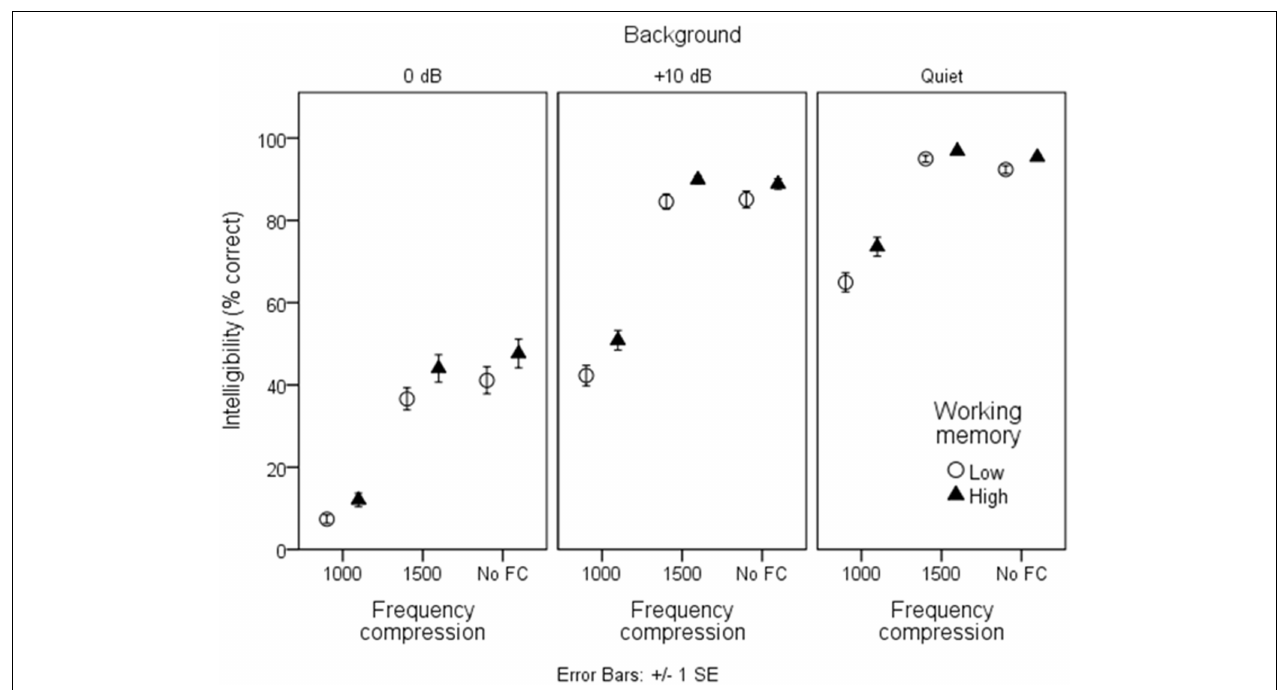
FIGURE 4 | As in Figure 3, but grouped by frequency compression